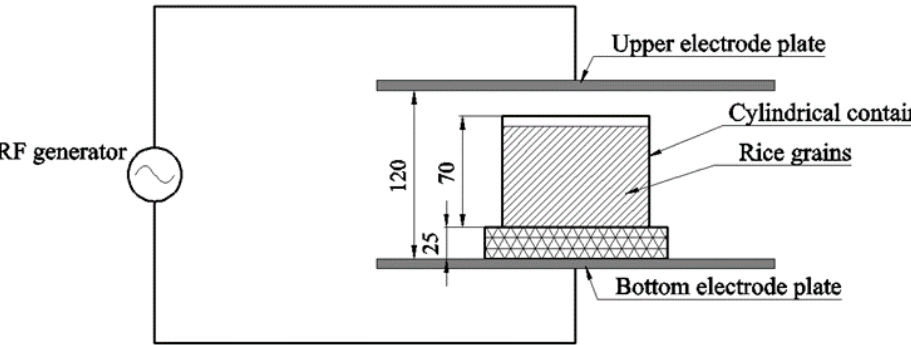
Figure 1. Schematic of the sample placed in the RF heating system (27.12 MHz, 6 kW). All dimensions are in mm.